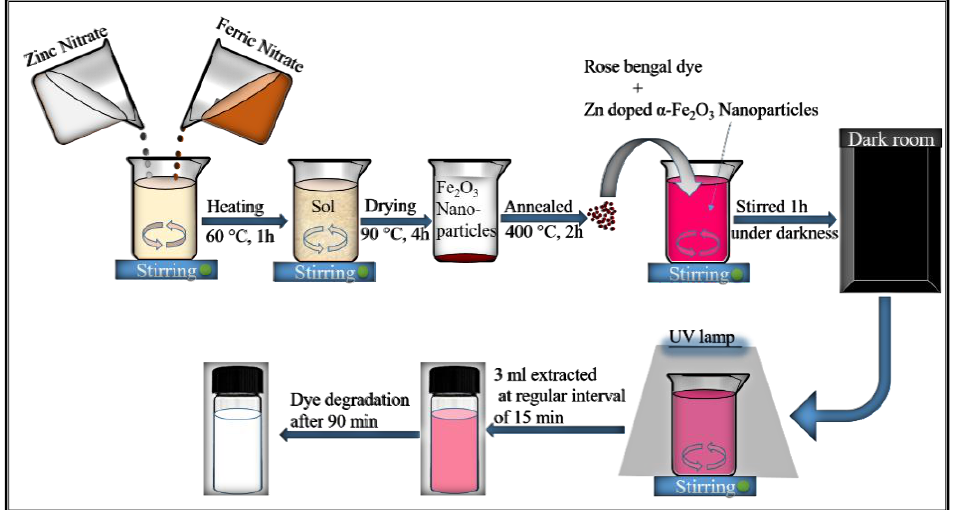
Figure 1. Schematic representation of synthesis and photocatalytic test of pure Fe 2 O 3 , Zn 2%, Zn 4% and Zn 6% nanoparticles.